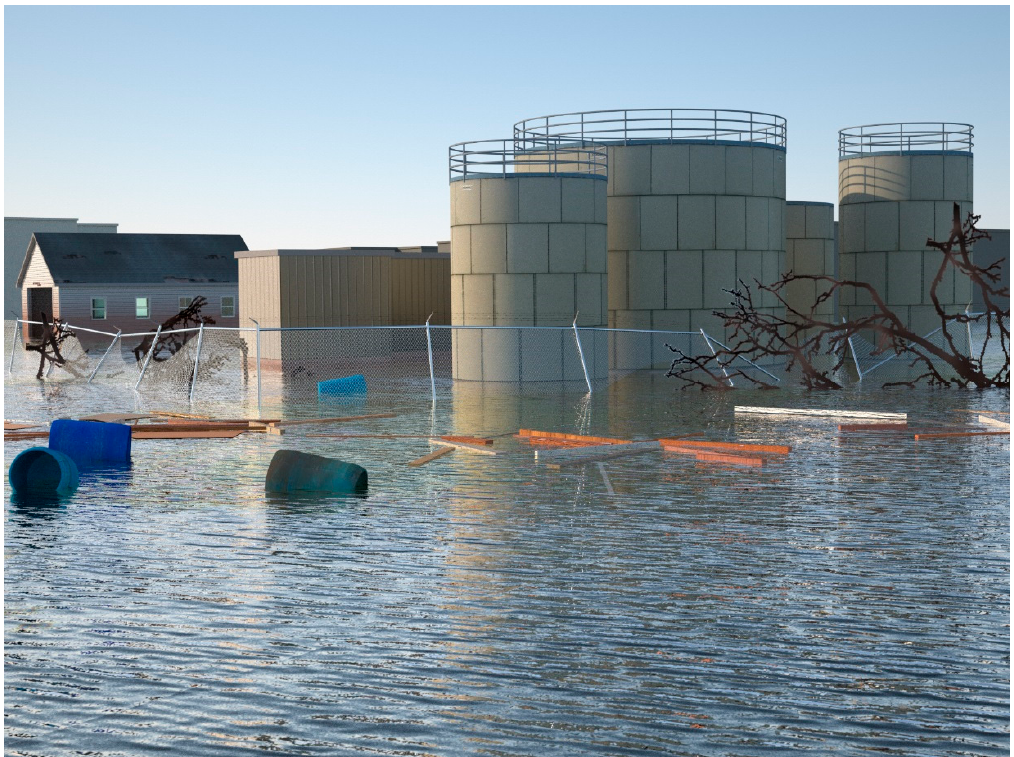
Figure 7. a realistic ground level visualizations of water treatment tanks in Galilee, Rhode Island, USA, intended to serve as an exemplar of damages post-storm. This depiction is controlled by the same underlying ocean and impact models used to create Figure 1.